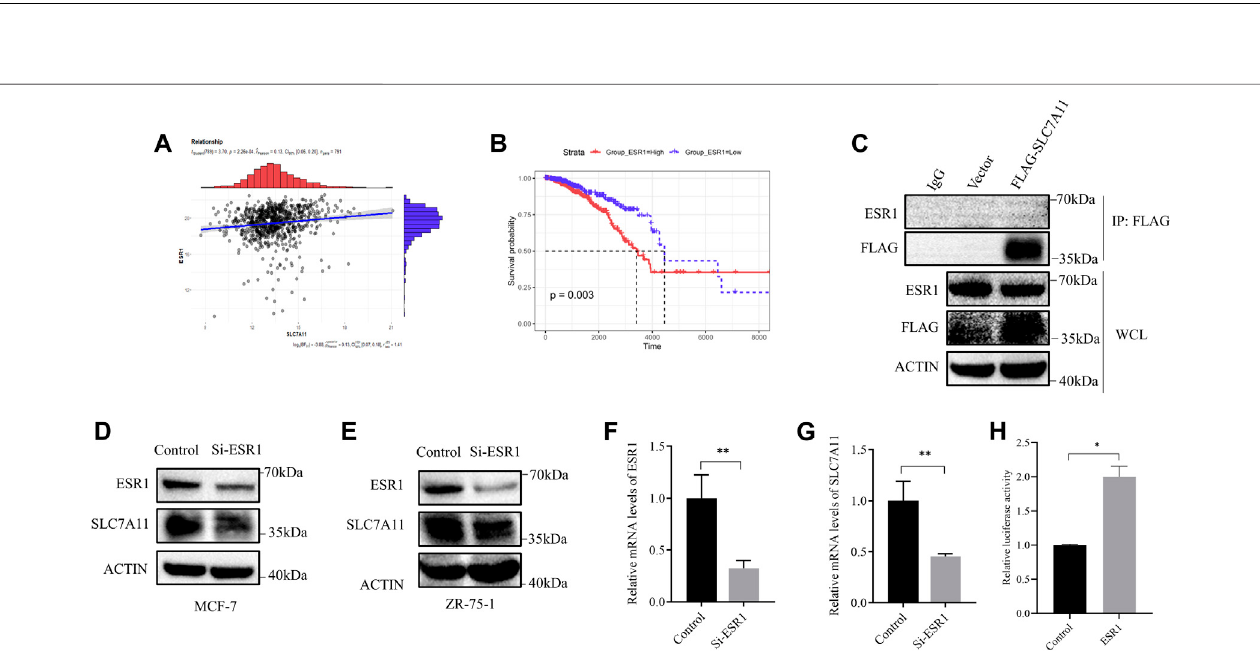
Frontiers in Cell and Developmental Biology |